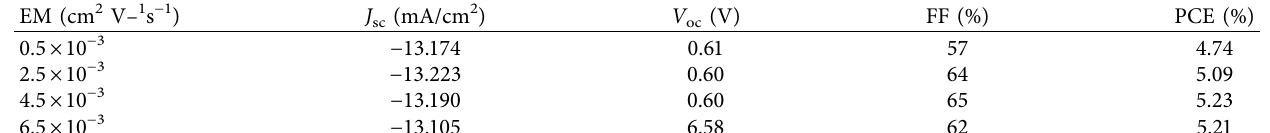
Table 4: Evaluated parameters of the cells for various thickness of EM.